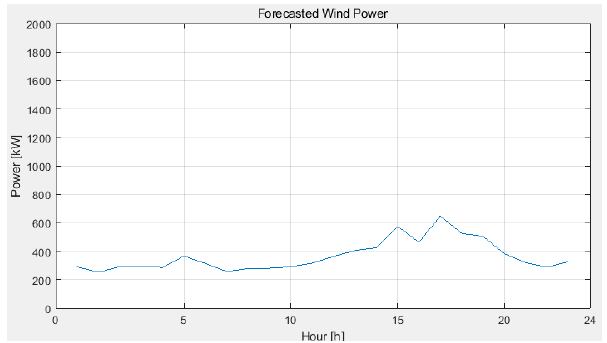
Figure 5. Scenario 3 wind power.